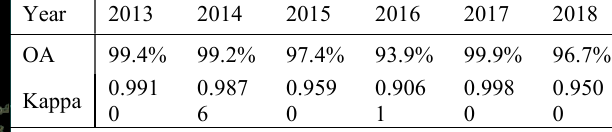
Table 1. The overall accuracies and kappa coefficients of SVM classification from 2013 to